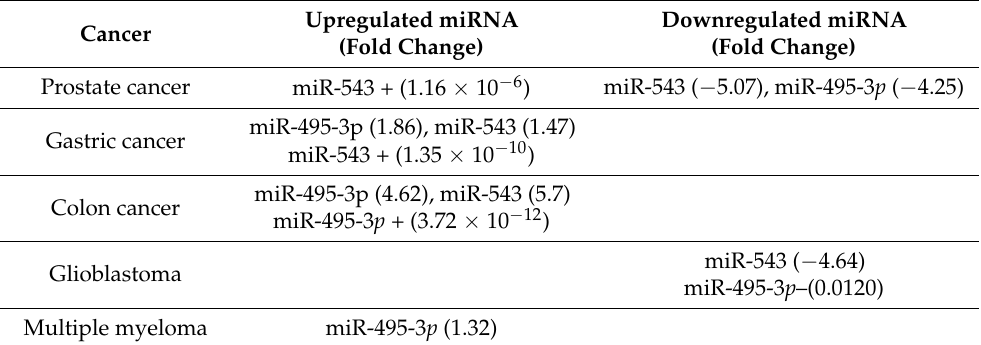
Table 2. Identification of common miRNAs (patients vs. controls).